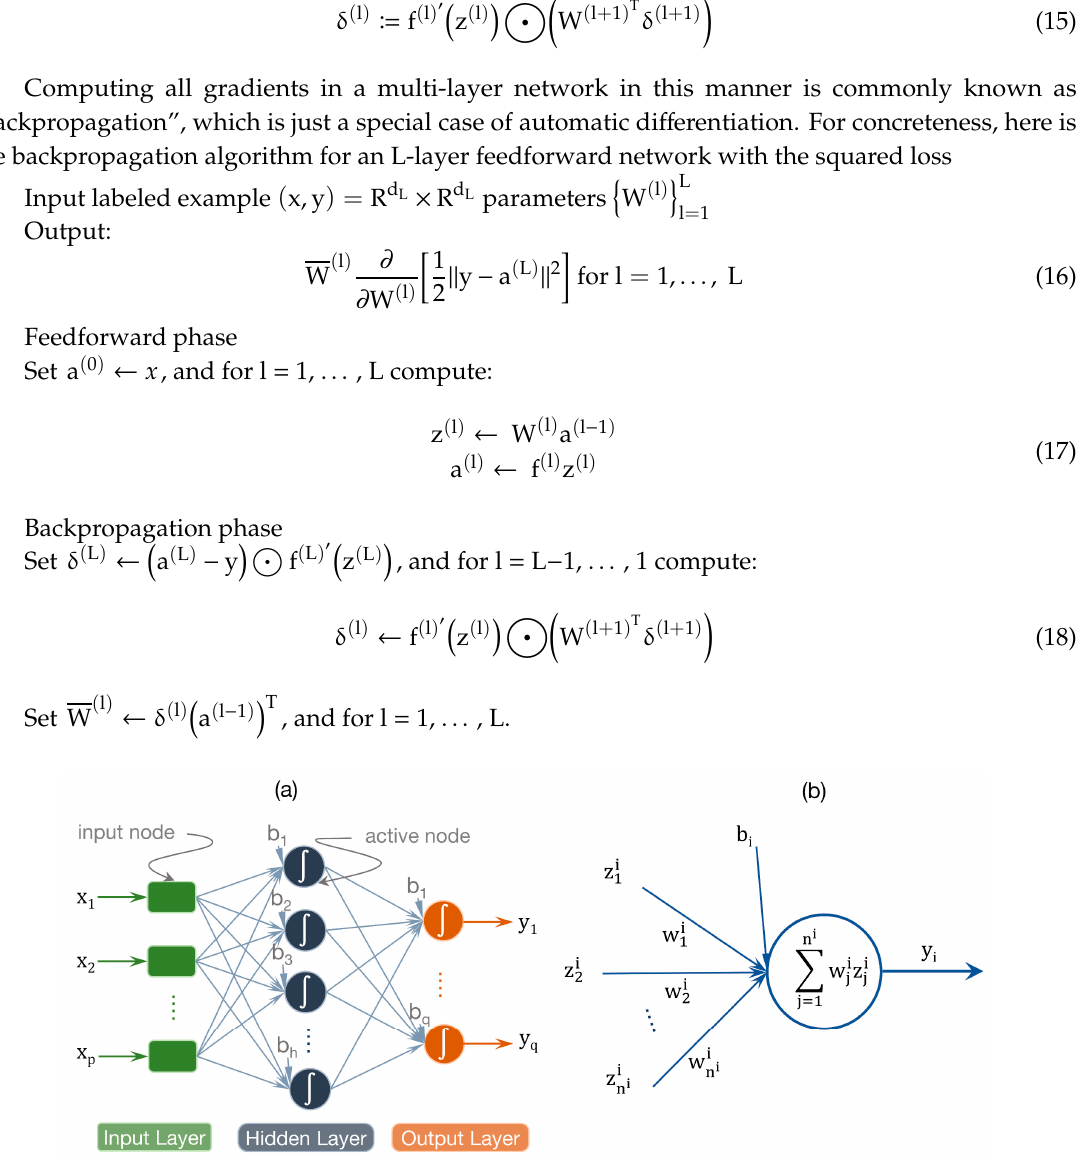
Figure 5. Three-layer feed forward neural network ( a ) where input layer has p input nodes, hidden layer has h activation functions, and output layer has q nodes. ( b ) A node of the network.